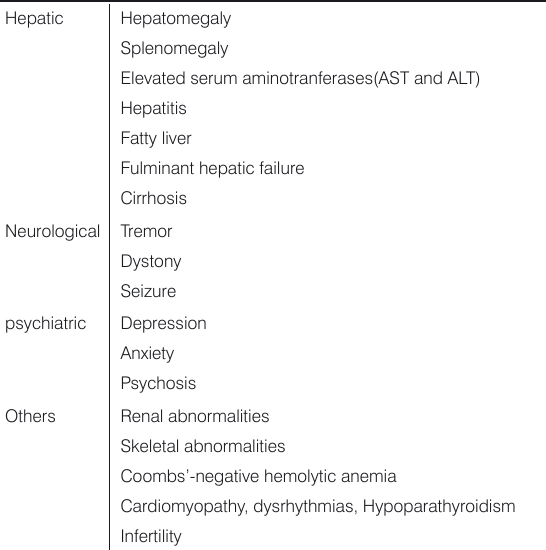
Table 1. Clinical features of Wilson’s